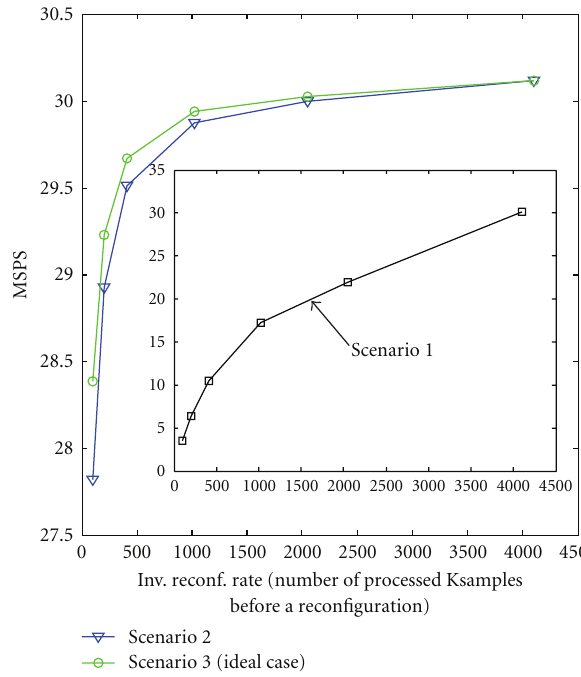
Figure 15: DPR system performance for full-filter reconfiguration.